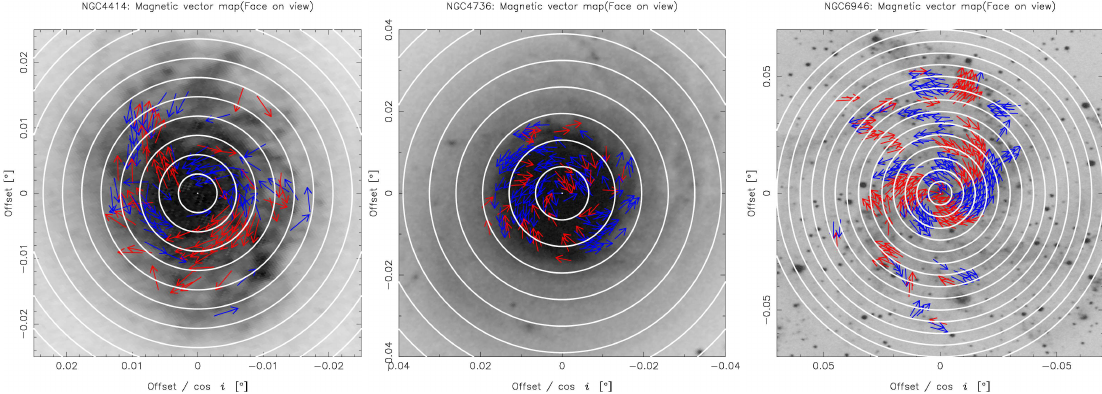
Figure 5. Face-on views of magnetic-field-vector maps of NGC 4414 ( left ), NGC 4736 ( middle ), and NGC 6946 ( right ), superposed on optical B-band images taken from DSS. Each image was rotated by position angle and horizontally enlarged by 1/cos i . Circles are overlaid at 500 pc